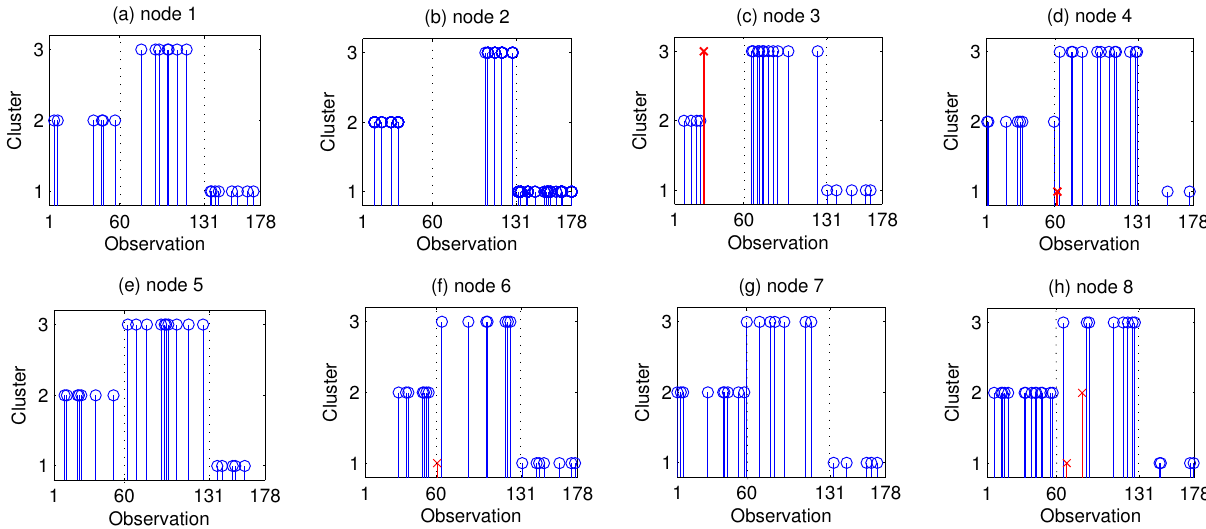
Figure 8. Clustering results of the wine dataset at ( a – h ) Node 1 ∼ Node